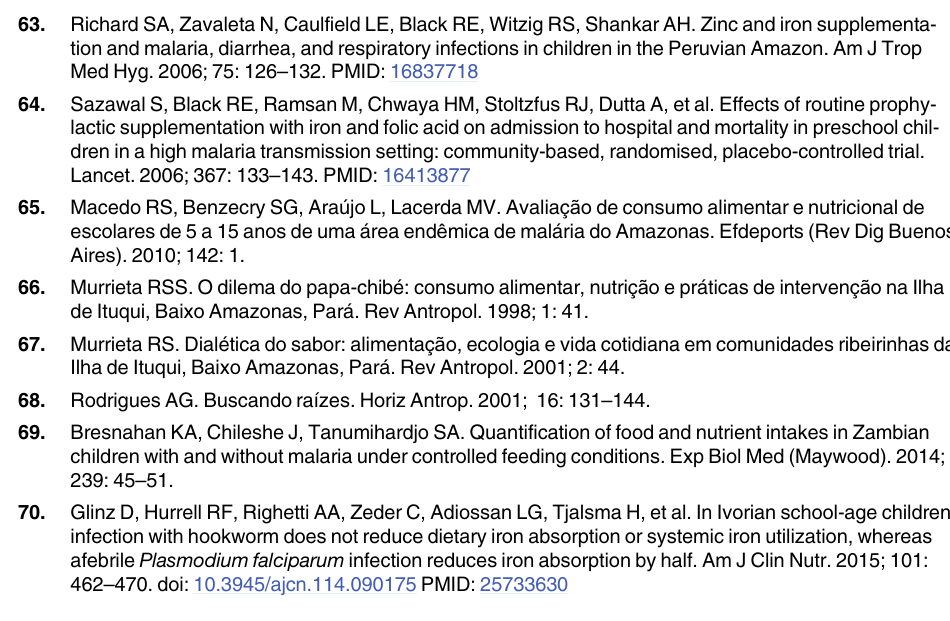
PLOS ONE | DOI:10.1371/journal.pone.0151019 March 10,